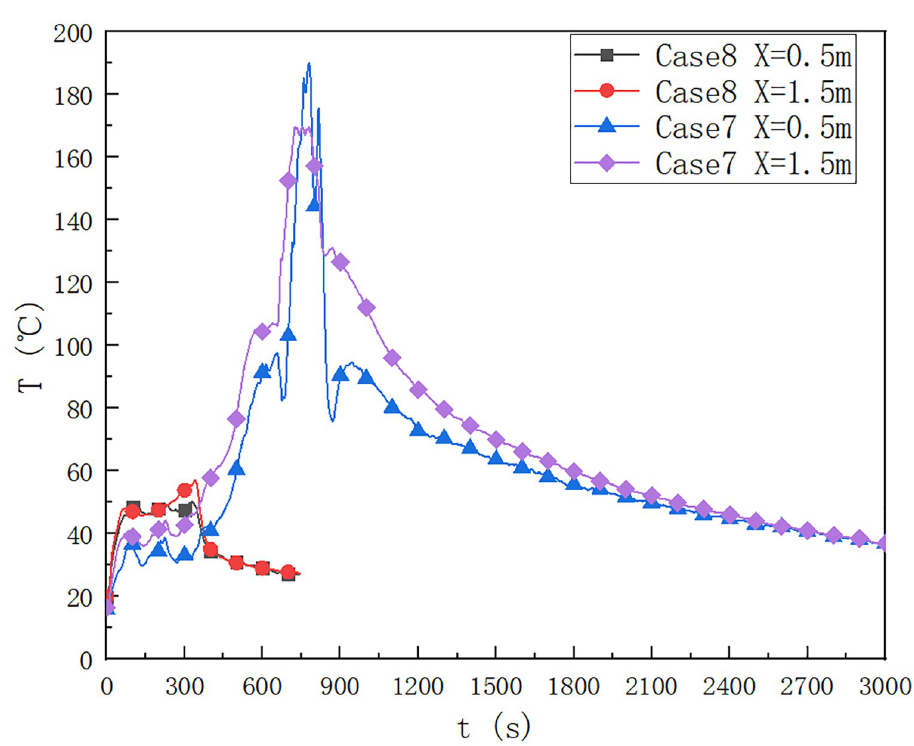
Fig 11. Temperature below the ceiling of the cable compartment in the utility tunnel at 7 and 8 at a distance of 0.5 m and 1.5 m from the fire